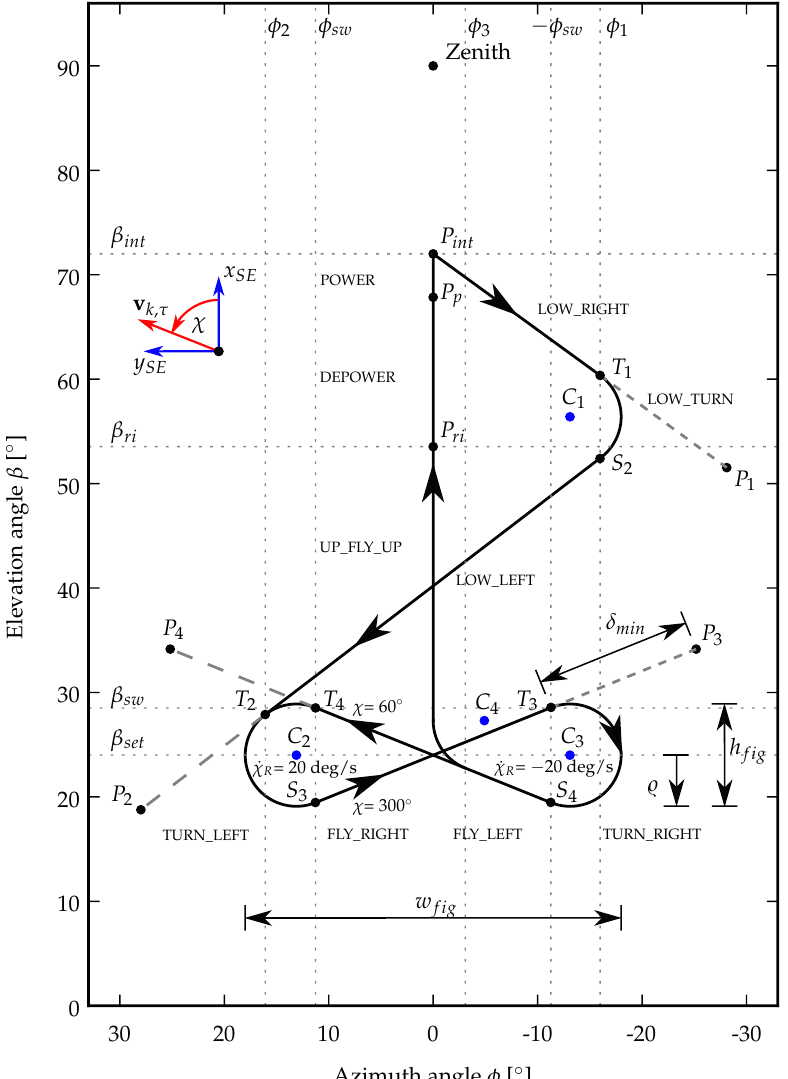
Figure 4. Flight-path planner (FPP) for the entire pumping cycle, including the four-step planner for down-loop figure-of-eight maneuvers: first, turn left, then steer towards attractor point P 3 , then turn right, and finally steer towards attractor point P 4